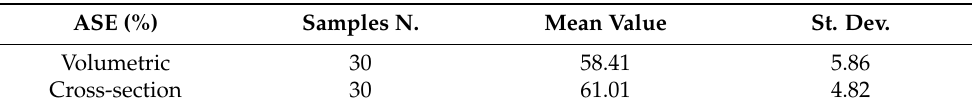
Table 2. Anti-Shrinkage Efficiency (ASE) of heat-treated ayous wood referred to as volumetric and cross-section